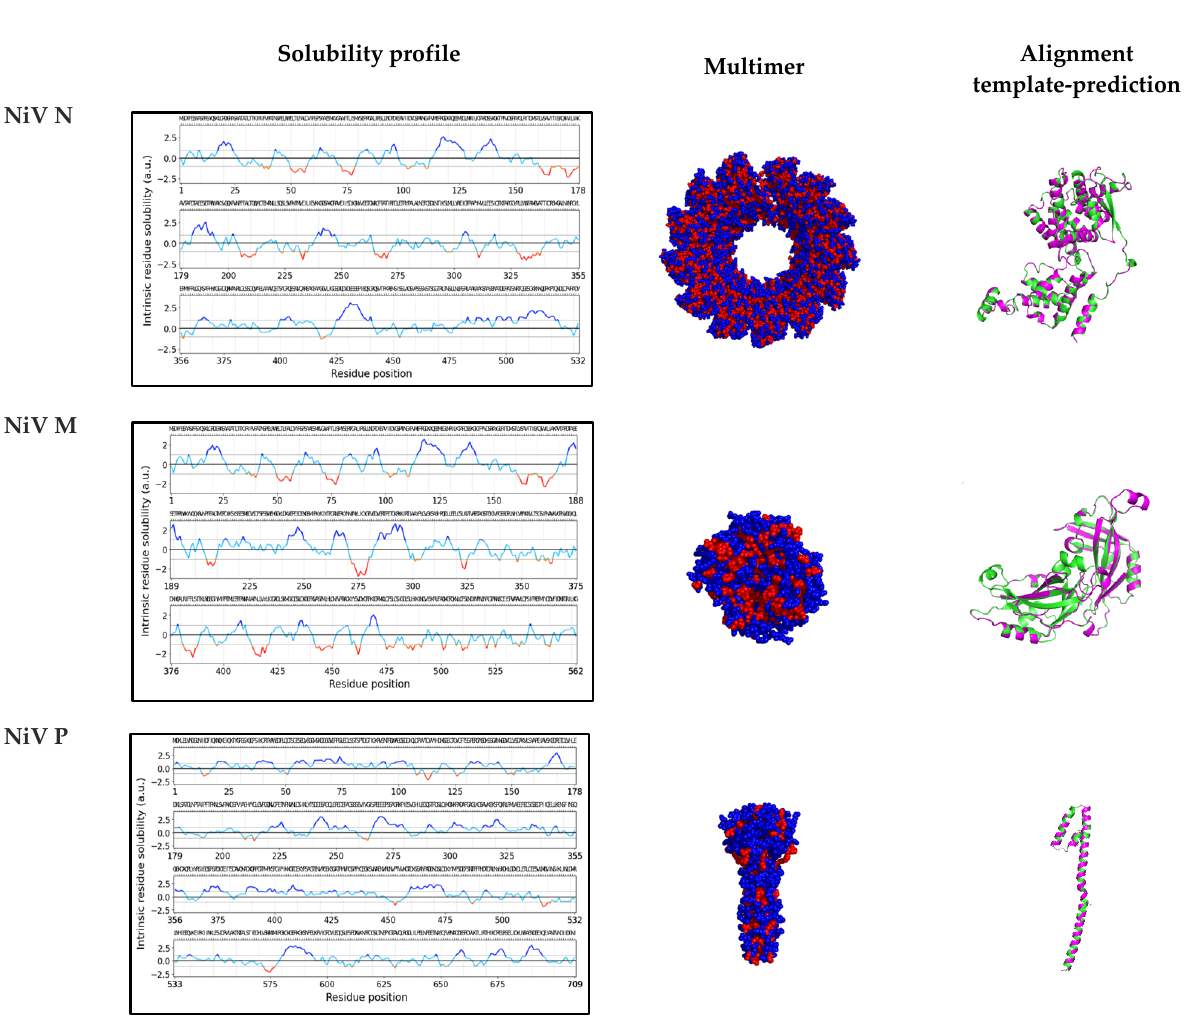
Figure 6. Solubility and three-dimensional analysis of NiV N, M, and P . On the left, solubility profiles of NiV N, NiV M, and NiV P are shown. The amino acid sequences of the NiV nucleoprotein N, the matrix protein M, and the phosphoprotein P were analyzed using the CamSol method in order to generate a solubility profile. Each amino acid in the protein sequence was assigned a score. Regions with scores higher than 1 denote highly soluble regions, while scores smaller than − 1 indicate poor solubility. In the middle and on the right, three-dimensional (3D) representations of both: (i) the multimeric structure of NiV N, NiV M, and NiV P, with hydrophobic amino acids shown in red and non-hydrophobic amino-acids shown in blue, and (ii) the alignment of the NiV N, NiV M, and NiV P predicted monomeric structure (in magenta) and the monomeric template (in green) used in (i). The α -helices and β -sheets are indicated as ribbons and wide arrows,